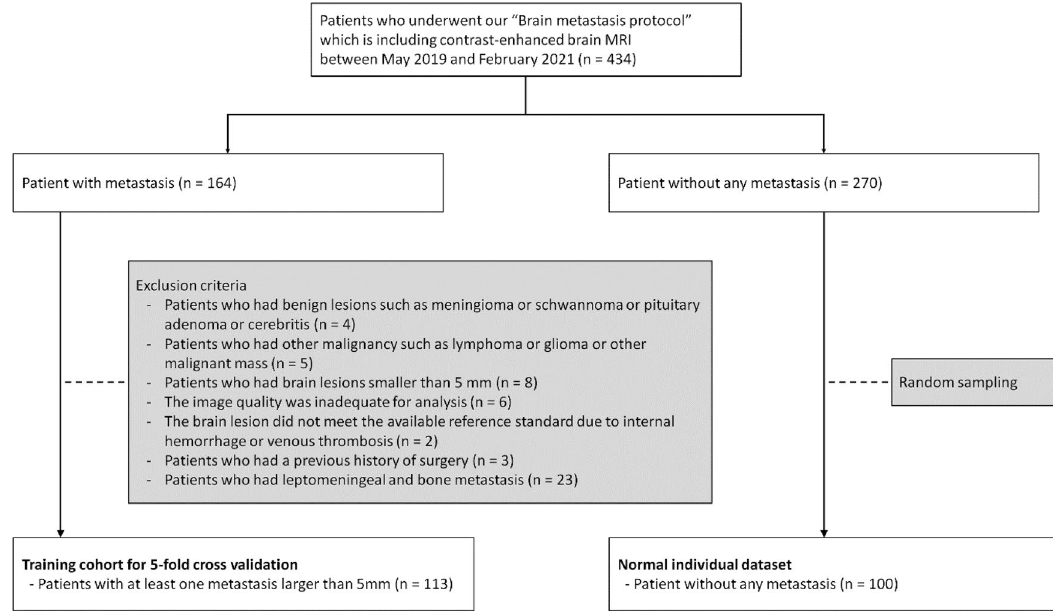
Figure 4. The flowchart of the study population.